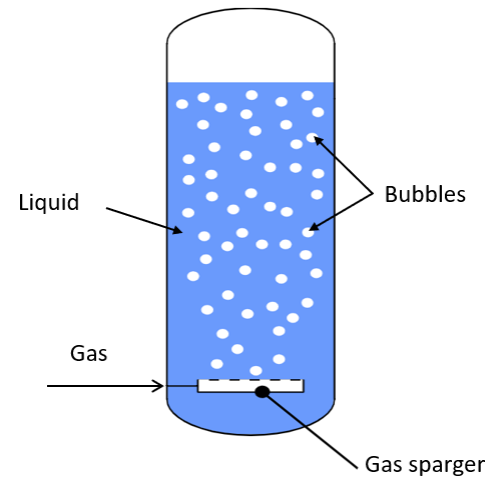
Figure 1. Bubble column reactor.